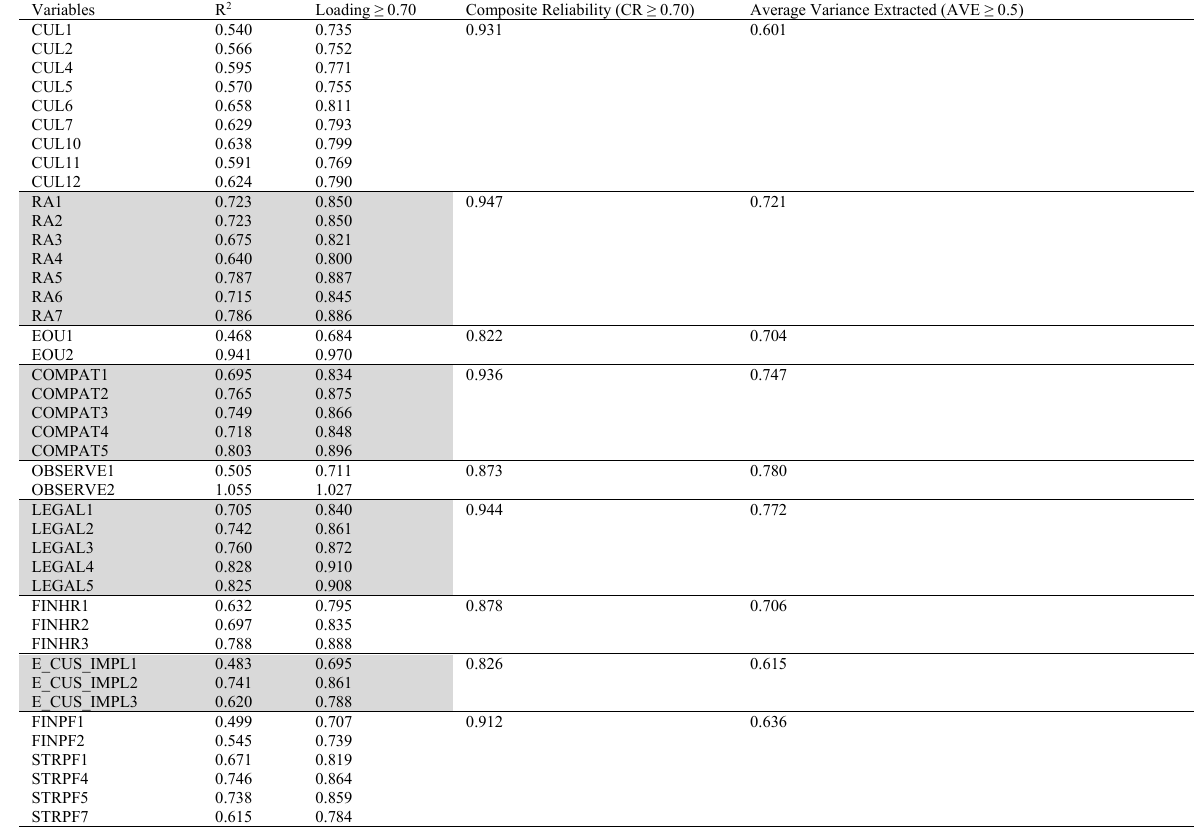
Measurement Model Assessment with CFA Variables R 2 Loading ≥